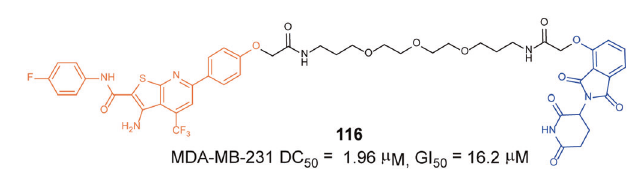
Fig. 28 The representative PROTAC targeting FOXM1